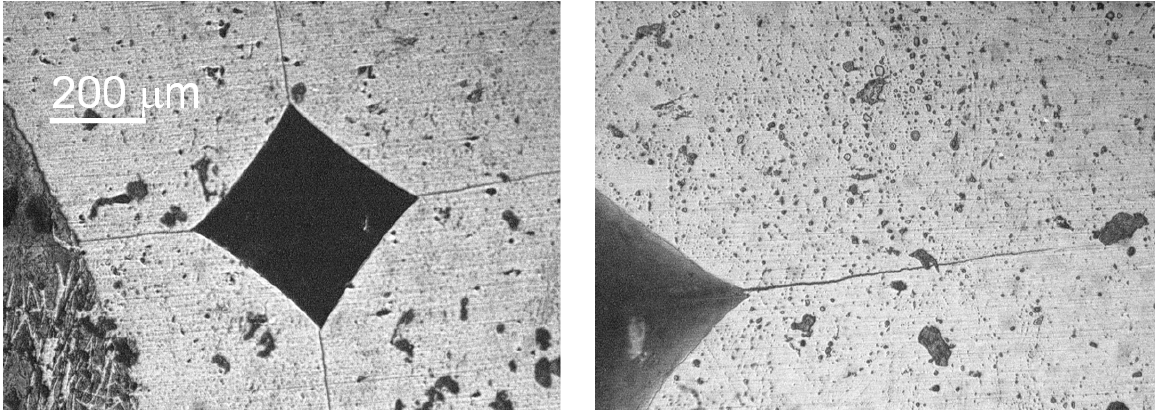
Figure 3: Result of Vickers indentation on a ZrO 2 specimen.